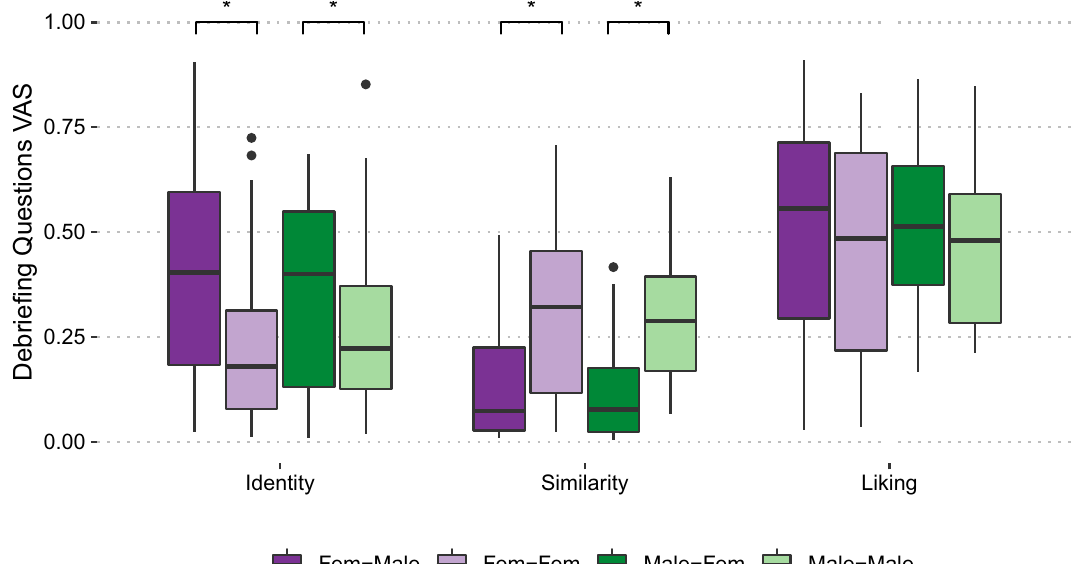
Figure 6. Debriefing questions. Debriefing question ratings. The data are separated by Sex and Group; median and interquartile ranges are displayed. Identity : Explorative ART ANOVA revealed a significant effect for Group, i.e., participants who swapped into a different-gender avatar felt more like their decisions were influenced by the virtual identity than those who swapped into a same-gender avatar. Similarity : Explorative ART ANOVA revealed a significant effect for Group, participants who swapped into different-gender avatars reported lower perceived similarity to their physical appearance than those who swapped into a same-gender avatar. Liking : No significant effects were